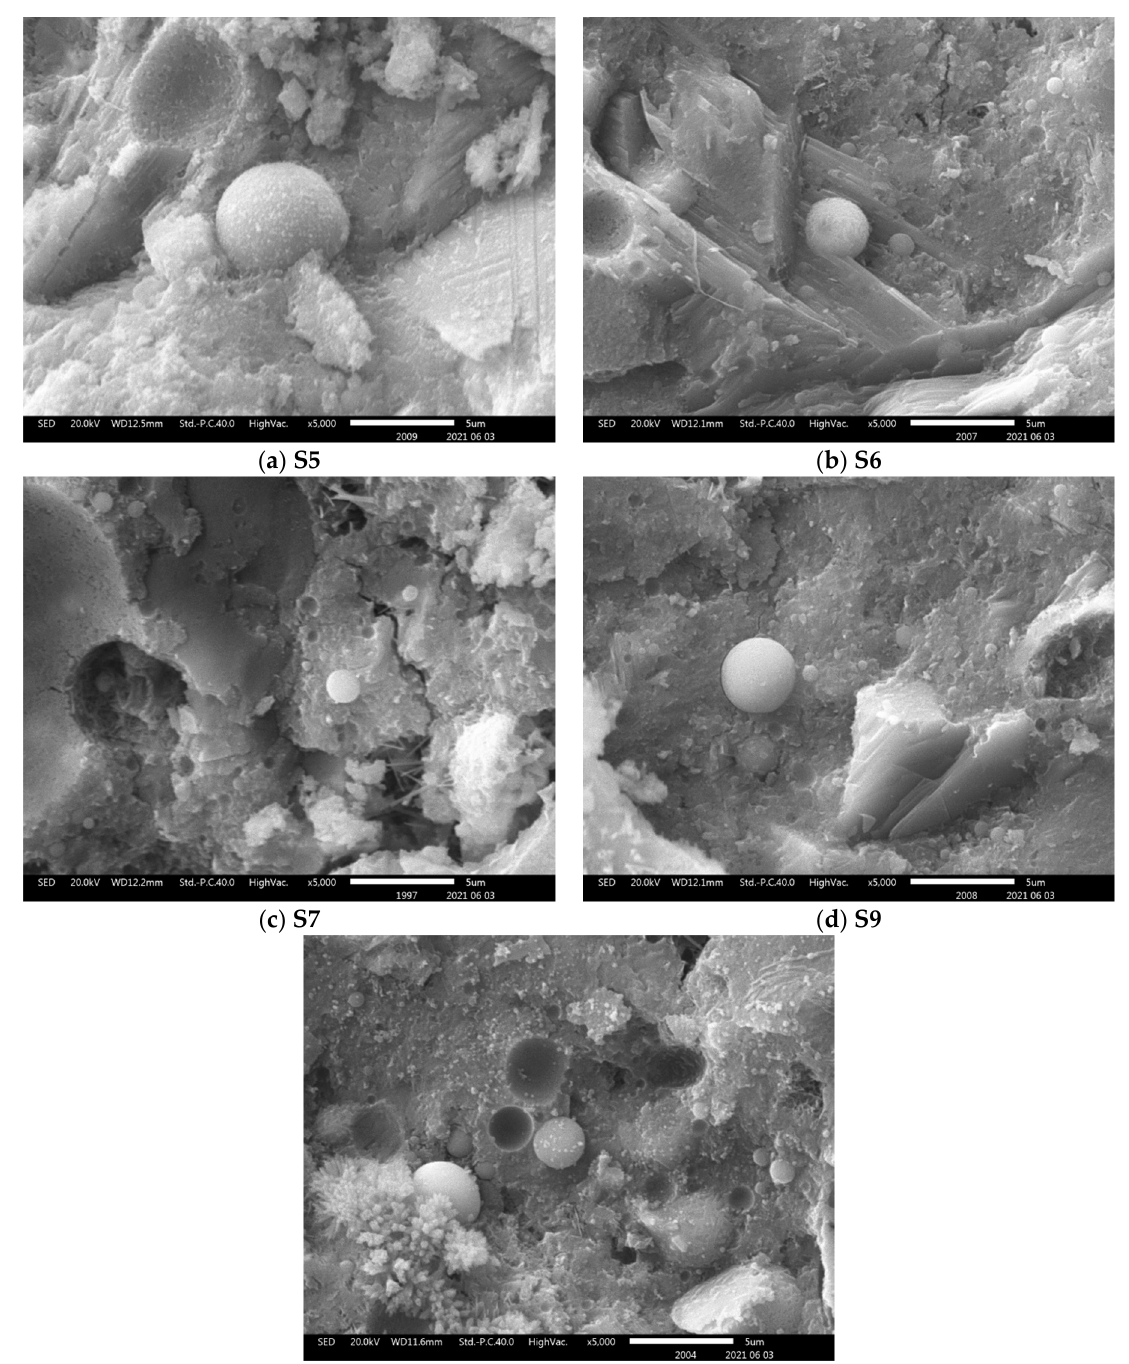
Figure 18. SEM images of samples at 28 days (magnification is